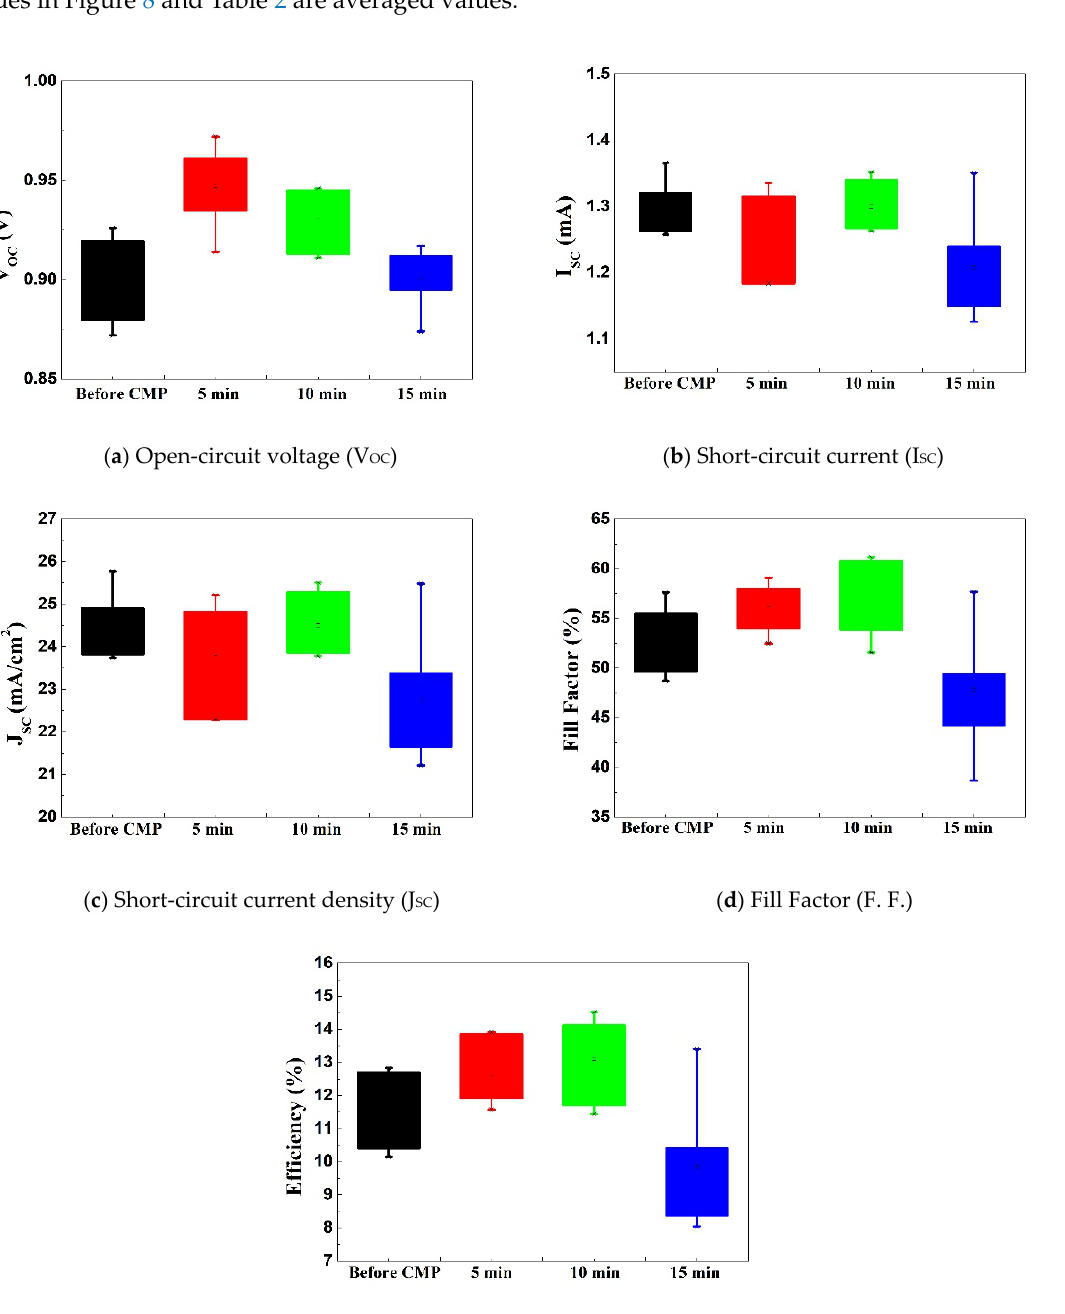
Figure 8. Photovoltaic properties of perovskite solar cells before and after CMP surface treatment; ( a ) open-circuit voltage, ( b ) short-circuit current, ( c ) short-circuit current density, ( d ) fill factor, and ( e ) power conversion efficiency of the prepared perovskite solar cells (PSCs) device. The box plots of ( a )–( e ) were drawn vertically indicating the data distribution of photovoltaic parameters recorded from the solar simulator. They have minimum values, maximum values, and average values that are displayed at the middle line in each box.